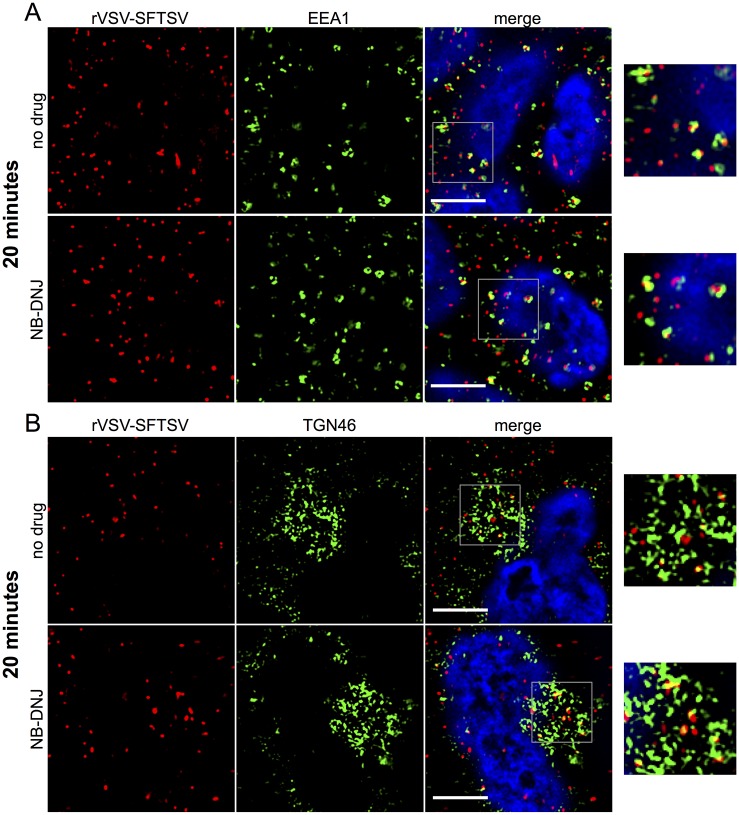
Immunofluorescence microscopy of incoming virus particles, 20 minutes.(A, B) A549 cells were plated onto glass coverslips and the following day replaced with media containing NB-DNJ (200μM) or left untreated. Forty-eight hours later, cells were chilled to 4°C on ice, then rVSV-SFTSV was bound by centrifugation (1200xg, 30’, 4°C). Following centrifugation, media was replaced with pre-warmed media (37°C) and the cells placed in a 37°C incubator for 20 minutes before fixation in 2% paraformaldehyde for 10 minutes. Cells were then immunostained for viral antigen (anti-VSV M, red), cellular markers (green), and nuclei stained with DAPI (blue). Images are representative from at least 3 independent experiments. (A) A549 cells co-stained for rVSV-SFTSV (red) and early endosome marker EEA1 (green). (B) A549 cells co-stained for rVSV-SFTSV (red) and trans-Golgi marker TGN46 (green). Boxes indicate zoomed-in regions. Scale bar represents 5μm.